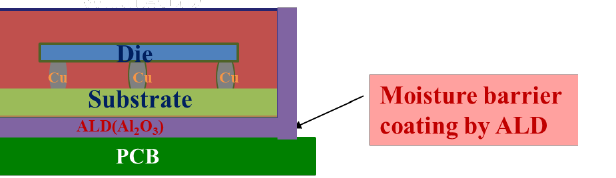
Figure 5. Schematic diagram showing the packaged printed circuit board structure and the coated alumina protection layer.